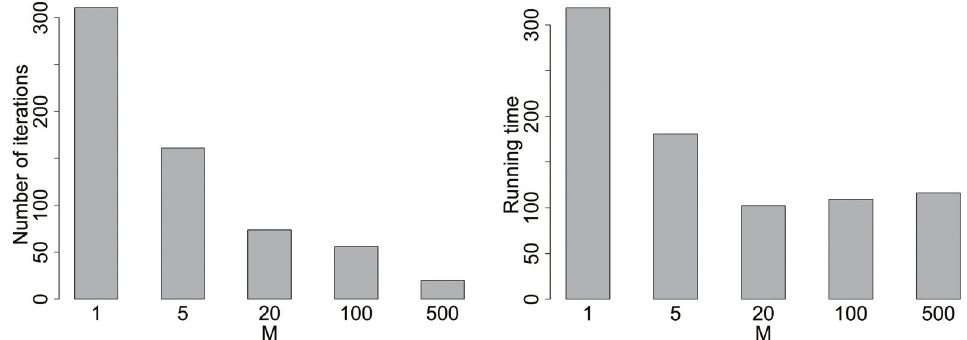
Fig 2. Effects of M for the instance LaSpezia(20,30). (a) The number of iterations that the ACO first achieves the best found solution; (b) The running time that the ACO first achieves the best found solution.